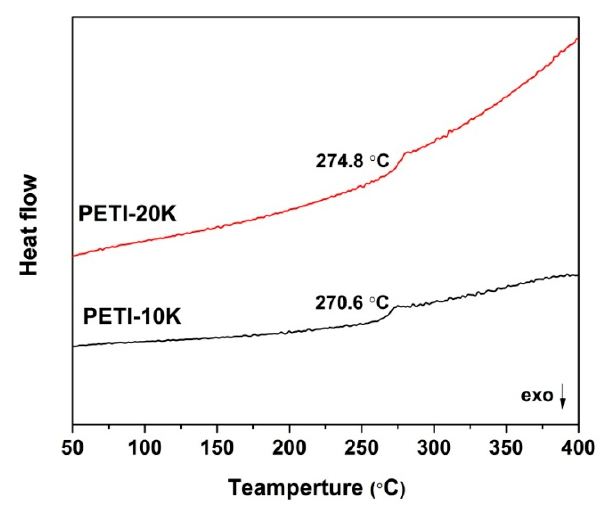
Figure 8. DSC curves of the electrospun PI nano ‐ fibrous membranes in nitrogen.